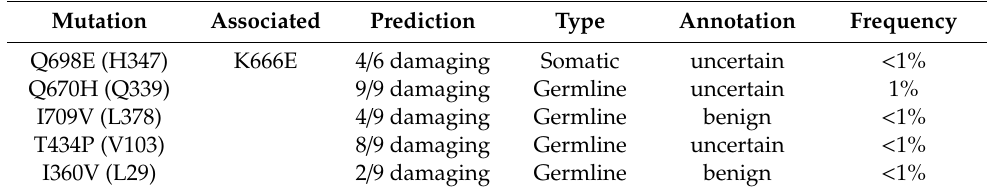
Figure 4. Close-up view of representative frames as extracted from the MD trajectories, depicting the intron (yellow) binding to Rds3 (green) in the nest of Hsh155 (pink) for ( A ) Bact , ( B ) Bact A-1U , ( C ) K335E Bact , ( D ) K335E Bact A-1U , ( E ) K335E Bact U-2C , ( F ) L378V Bact A-1U , ( G ) N295D Bact , and ( H ) N295D Bact A-1U models. Hydrogen (H)-bonds between Hsh155 residues and intron U +14 and U +16 phosphates are highlighted as white dashed lines. In the upper right corner, the red box highlights the intron/Rds3 contacts. In the lower left corner ( G ), it is depicted as the persistent H-bond network between R299, D295, K335E, and the intronic phosphates U +14 and U +16 . Table 1. SF3B1 (Hsh155 in yeast) isoforms with unclear clinical annotation. Prediction of their e ff ect is estimated on the basis of bioinformatics analysis (see Materials and Methods section). In brackets are the residues corresponding to yeast